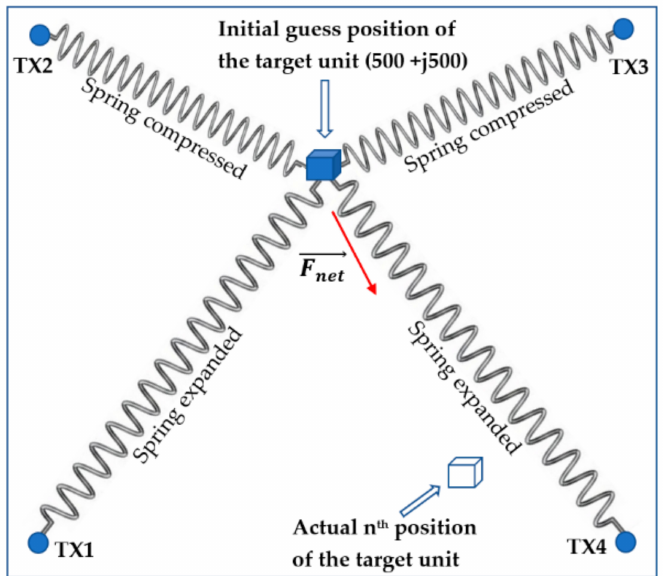
Figure 3. Application of spring-relaxation technique for location